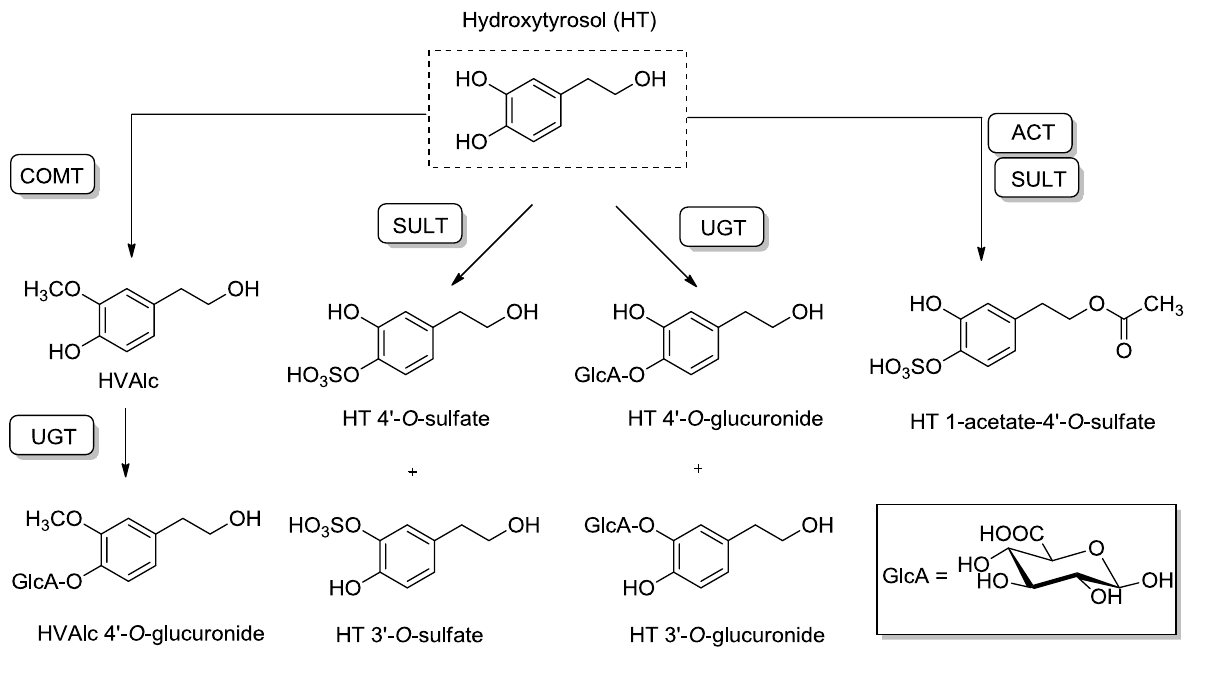
Figure 3. Biotransformation pathways of hydroxytyrosol (HT). Abbreviations: COMT: Catechol- O -methyltransferase; UGT: UDP-glucuronosyltransferase; SULT: Sulfotransferase; ACT: O -Acetyltransferase; GlcA: Glucuronic acid; HVAlc: Homovanillyl